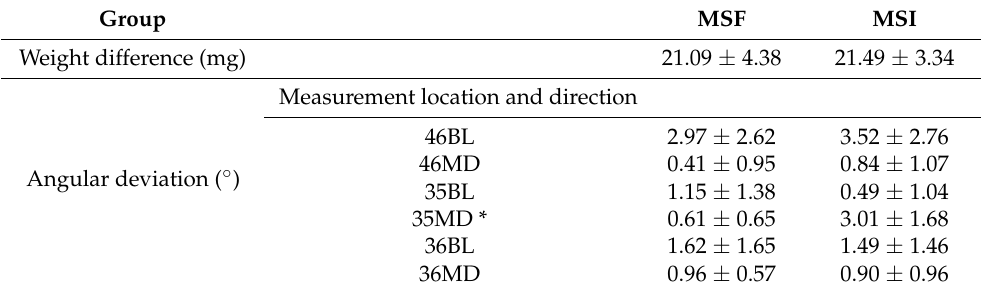
Figure 5. Preoperative and postoperative angular deviations of the MSF and MSI groups. The lines inside the boxes indi- cate median values, and the cross signs inside the boxes indicate mean values. The borders of the boxes indicate the 25th and 75th percentiles. The whiskers indicate the minimum and maximum values. The statistically significant difference is marked with an asterisk ( p < 0.05). BL, buccolingual. MD, mesiodistal.